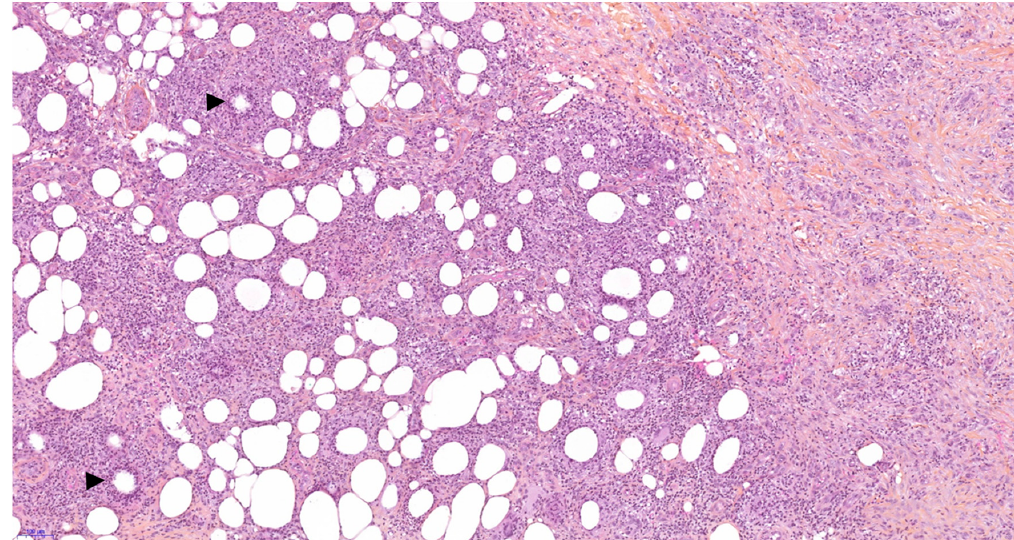
Figure 2. Skin biopsy, hematoxylin-eosin-Safran stain, ×100: Septal panniculitis characterized by a fibrosis of septa with lymphohistiocytic infiltrate spreading into the immediately adjacent lobule. Please note the collections of histiocytes and neutrophils around a central cleft known as Miescher’s granulomata (arrowheads) and strongly suggesting erythema nodosum [6].